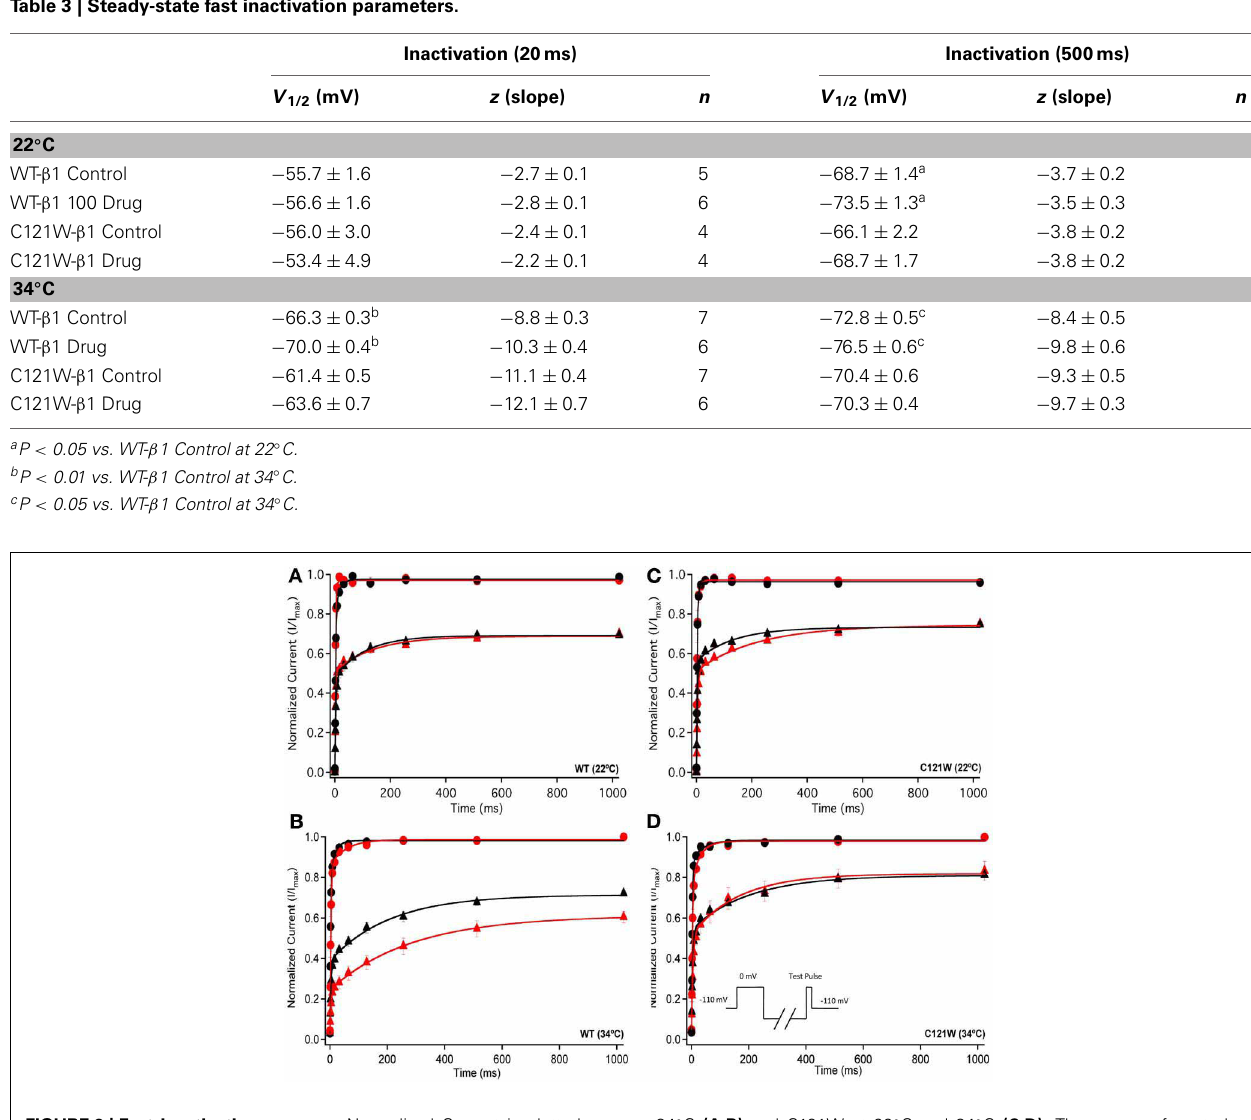
34 ◦ C (A,B) and C121W at 22 ◦ C and 34 ◦ C (C,D) . The means of control (shown in black) were compared to 100 μ M lacosamide (shown in red). Panel (D) shows an inset of the double pulse protocol measuring fast inactivation